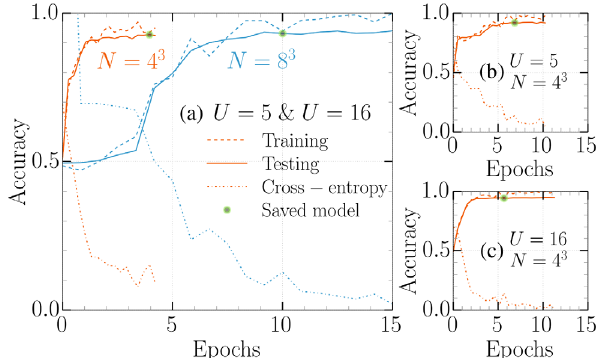
FIG. 6. Progress of the training process. Training accuracy for (a) simultaneous training with U ¼ 5 and 16, (b) U ¼ 5 alone, and (c) U ¼ 16 alone vs epochs. The location of last saved model is shown as a green circle in each panel. The testing accuracies for saved models are 92.7% (93.2%) for N ¼ 4 3 ( N ¼ 8 3 ) in (a), 91.9% in (b), and 94.3% in